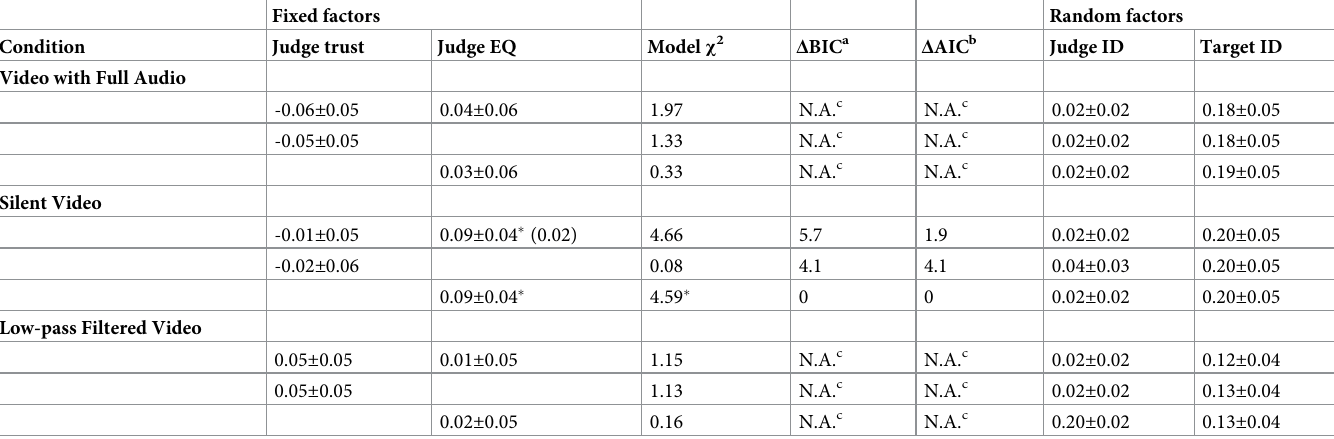
Table 8. Multilevel mixed regression models predicting absolute value of LORP-LSRP difference for secondary